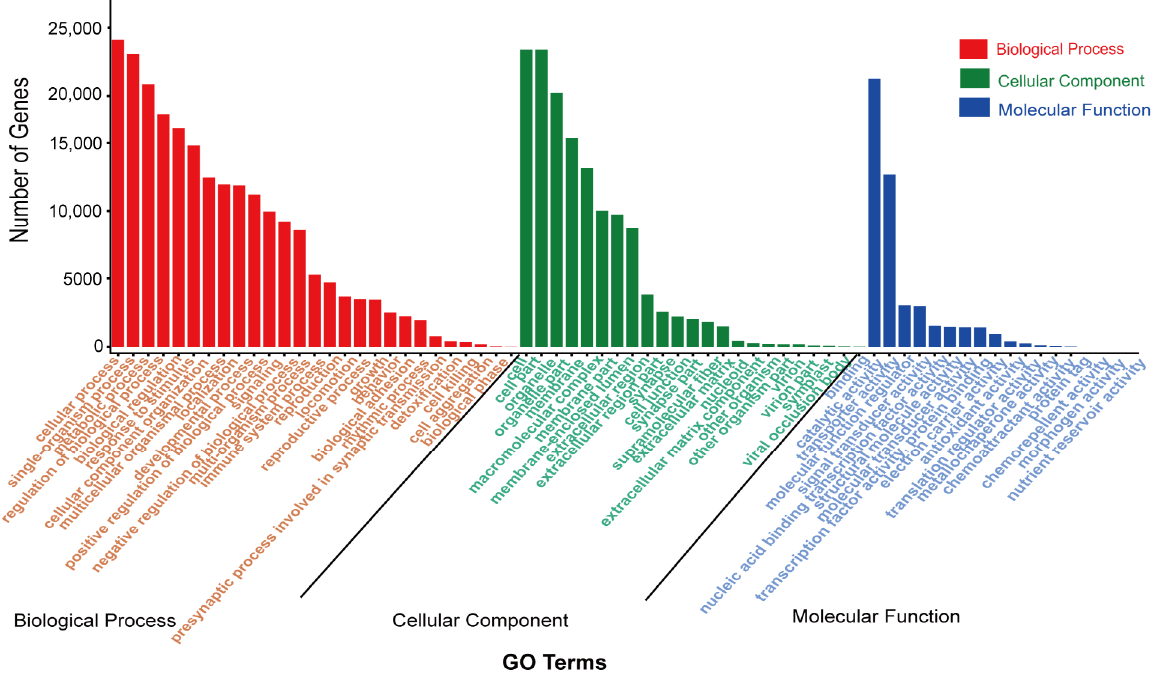
Figure 3. Distribution of GO terms for all annotated transcripts in biological process, cellular component, and molecular function.